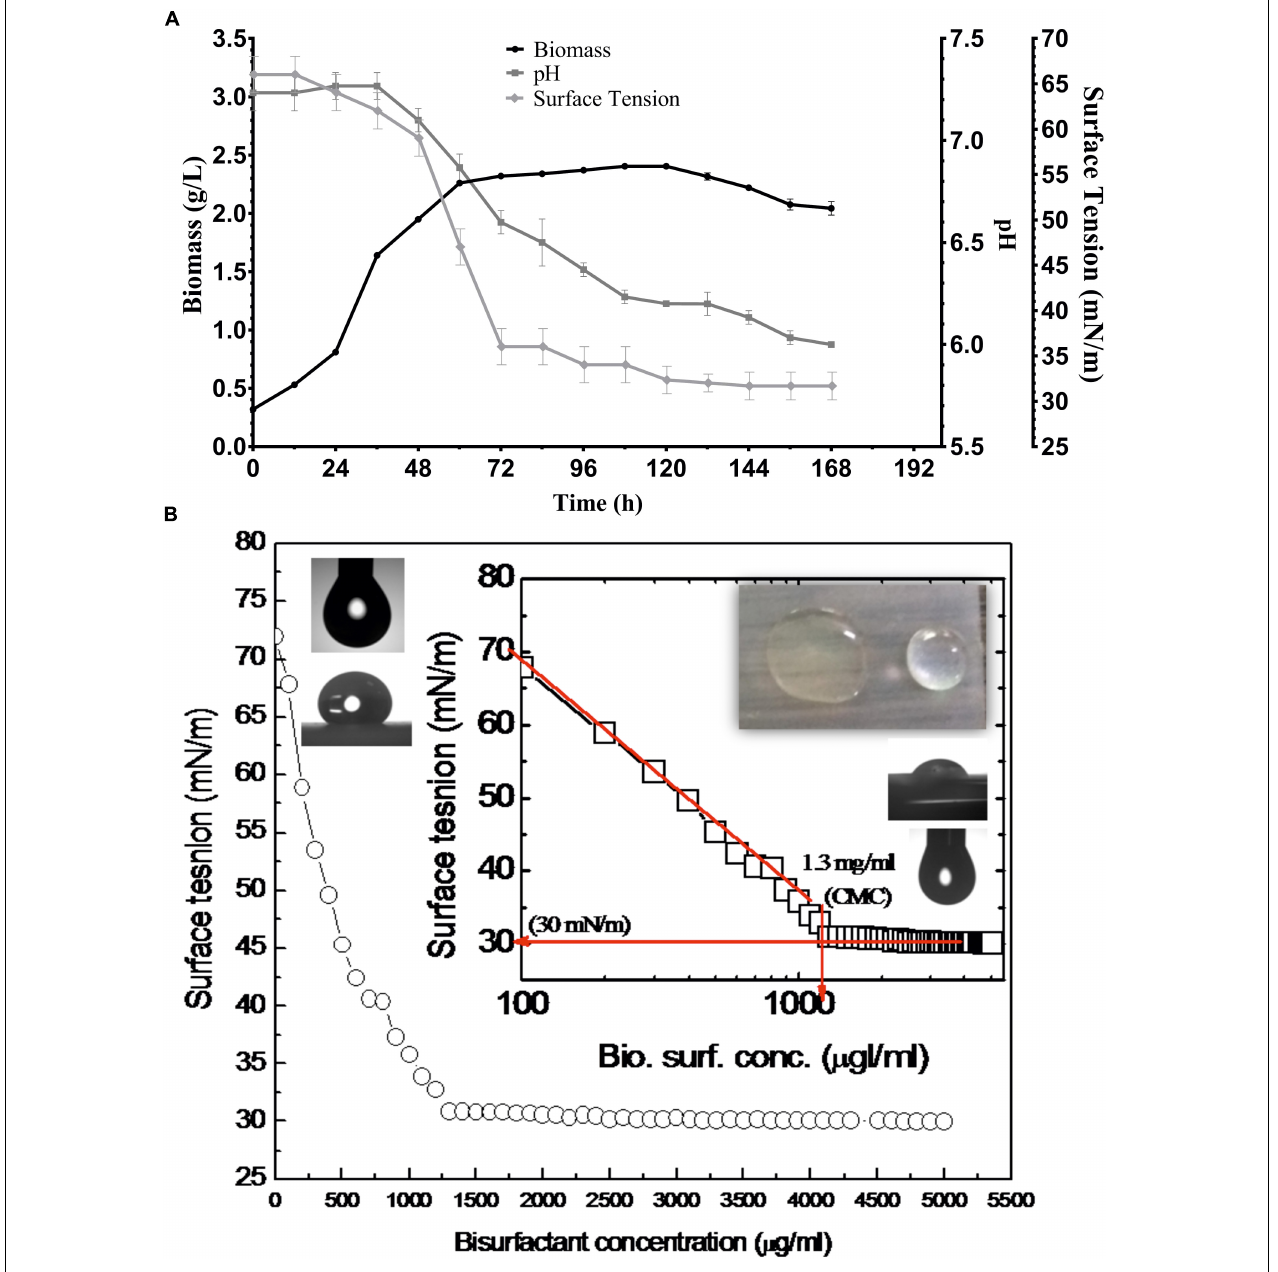
FIGURE 3 | (A) Growth and production of biosurfactant by P. maritimus SAMP. (B) Variation in SFT inset showing semi-logarithmic reflection of CMC value of SFT (mN/m) verses concentration of biosurfactant.